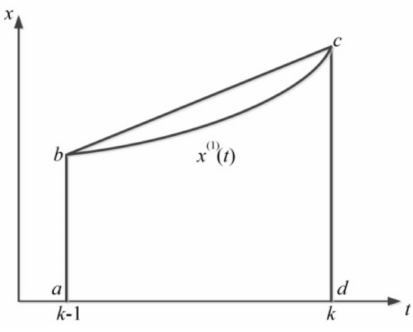
Figure 3. Error in the background